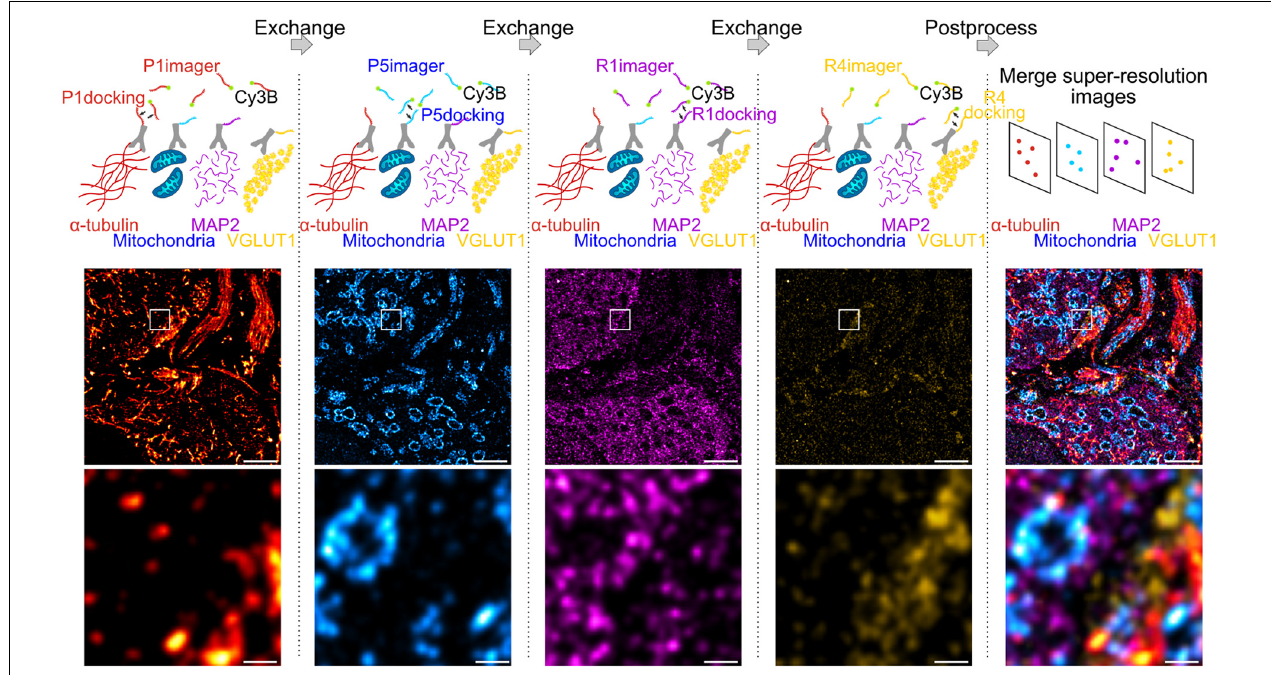
FIGURE 1 | Exchange DNA-PAINT of four targets imaged sequentially. Four protein targets in tissue were labeled with primary antibodies and their corresponding secondary antibody-docking strand conjugate (P1, P5, R1, or R4). The Cy3B labeled imager strands were imaged sequentially by strand type with wash steps between each imaging round. All SMLM rendered images depicting each target were merged to obtain a multi-protein super-resolved image. Scale bar 1 µ m (top) and 0.1 µ m (bottom)